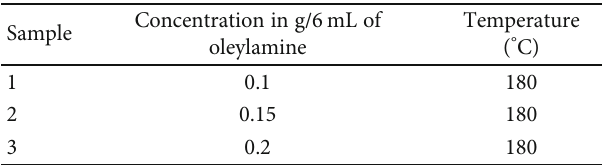
Table 1: Variation of precursor concentrations in 6 mL of